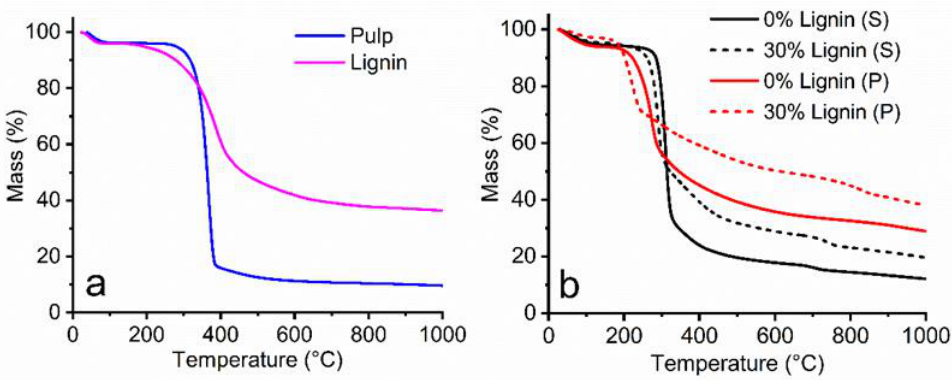
Figure 6. TGA curves in a nitrogen atmosphere for ( a ) the softwood kraft lignin and pulp raw materials and ( b ) the precursors spun with 0 and 30 wt% lignin using Systems S and P.